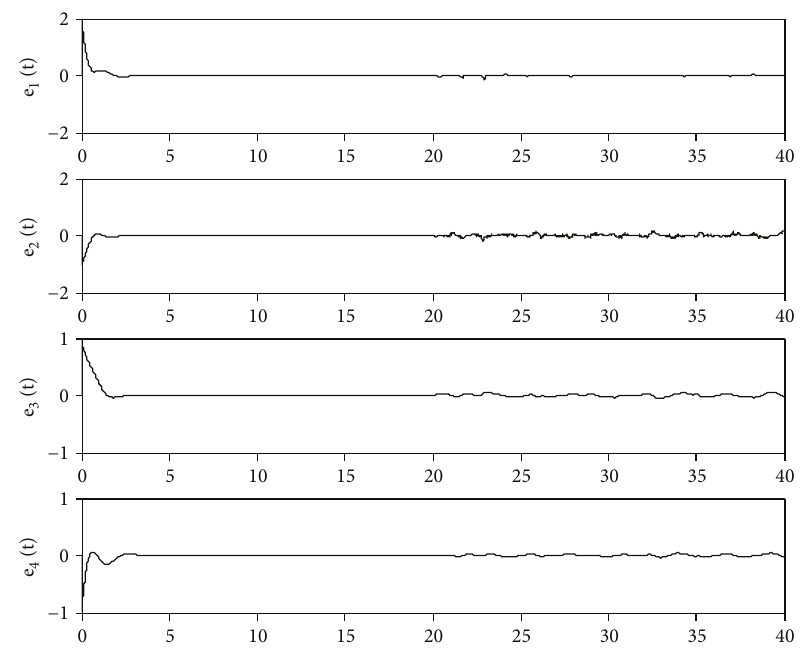
Figure 4: Time response of synchronization error variables with single-dimensional fuzzy